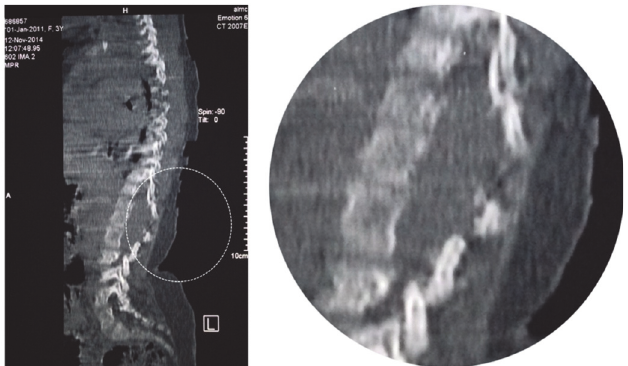
Figure 2: A sagittal CT section demonstrating a multiple level spinal dysraphism and deformity.